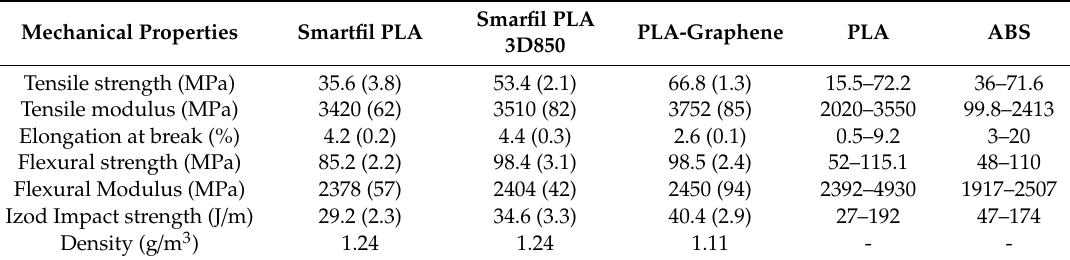
Table 1. The basic mechanical properties of PLA-based materials used in this work. Standard deviation is depicted in brackets. Typical ranges of mechanical properties for PLA and ABS materials manufactured by FFF technology provided by the manufacturers are also included for comparative purposes [12,13,50].